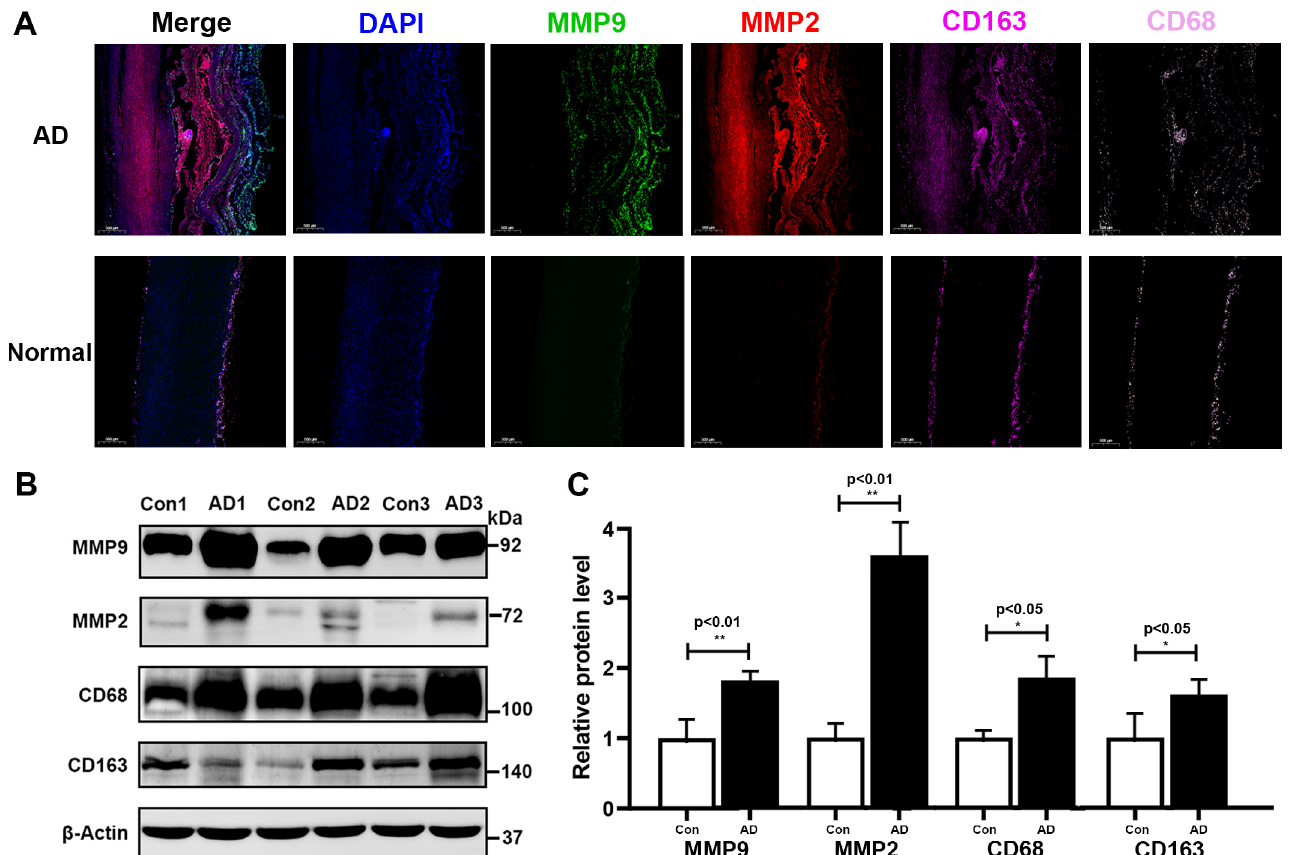
Figure 8. Detection of macrophage markers and metallomatrix proteinases in AD and normal tissues. ( A ) Representative mIF images of normal and dissected human ascending aortas stained with DAPI (blue), MMP9 (green), MMP2 (red), CD163 (magenta), and CD68 (pink) (Magnification: ×20). ( B ) Western blotting experiments showing the protein expression levels of MMP9, MMP2, CD163, and CD68 in AD and normal tissues. ( C ) Bar graph of protein expression in AD tissue relative to normal tissue. * represents p < 0.05; ** represents p < 0.01. mIF: multiplexed immunofluorescence.